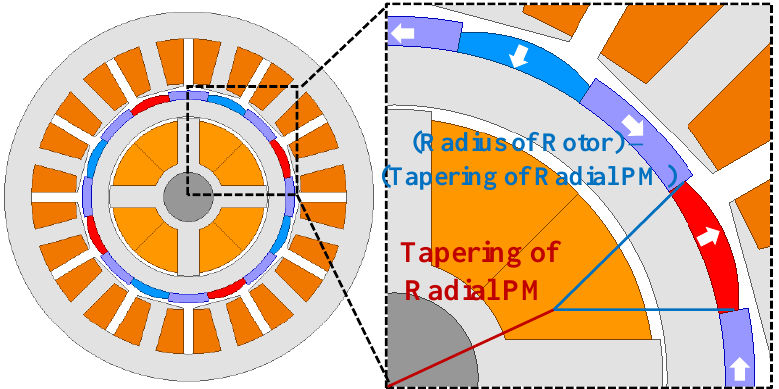
Figure 18. Rotor variable for tapering of radial PM.